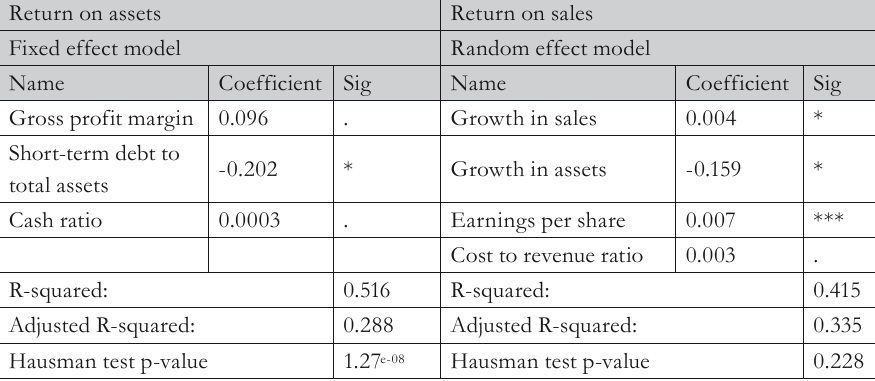
Tab. 9 - Miscellaneous: significant variables predicting ROA and ROS. Source: author’s own